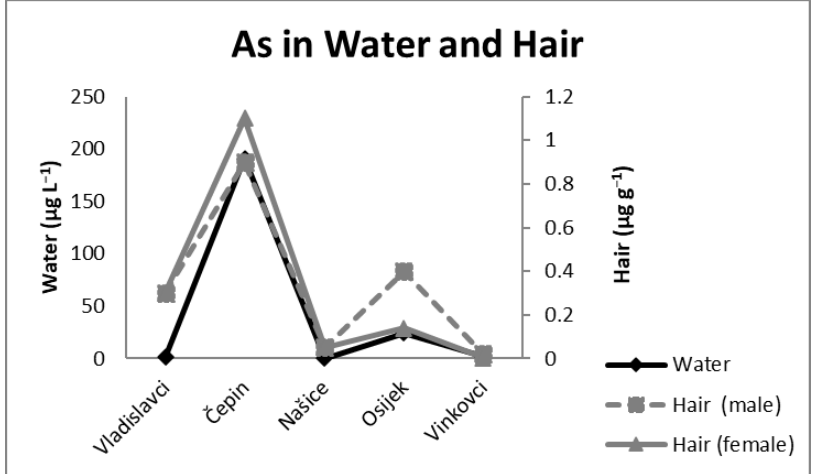
Figure 2. Relationship between median arsenic concentrations in water and hair. f — female; m — male.